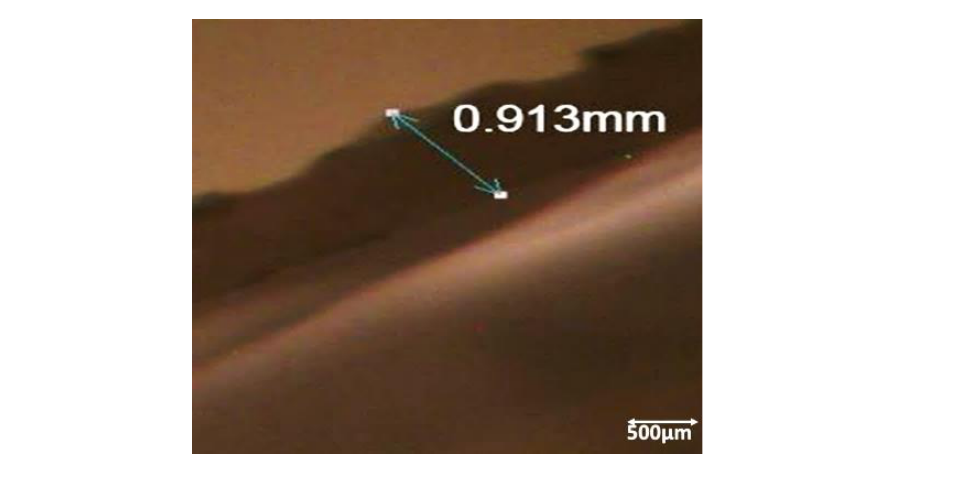
Figure 8. Stereomicrograph of the cross-sectional area of the deposited Ag-NP thin-film on the PDMS substrate.